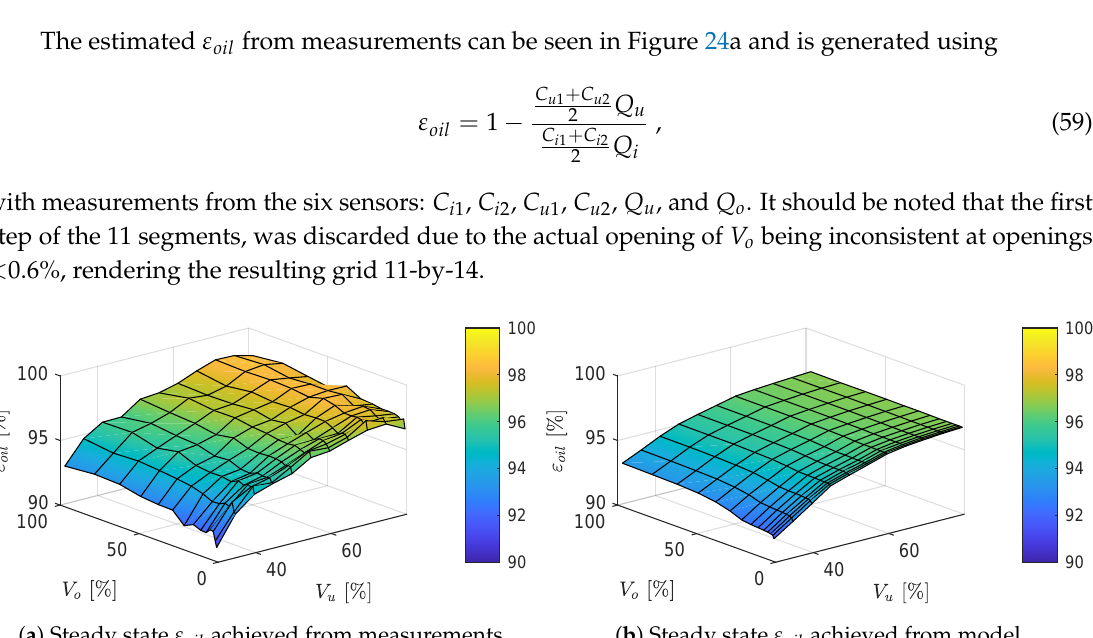
Figure 23. Steady state PDR achieved from measurements.